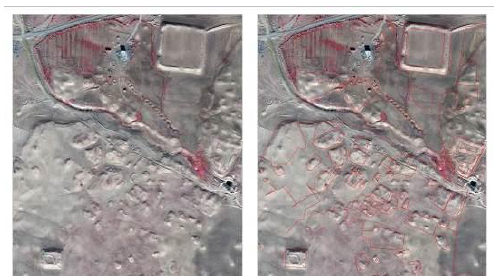
Figure 19 – Pleiades orthophoto of the Makhmúr al-Qadíma site with overlaid objects of interest on the right picture